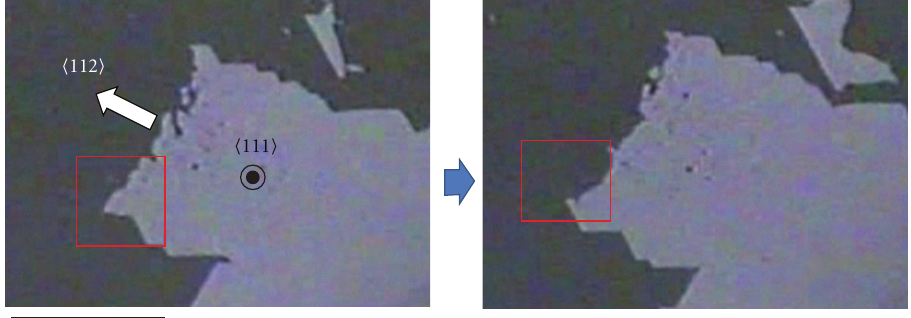
Figure 16: Growth behavior of Si (cid:4) 112 (cid:5) faceted dendrite observed perpendicular to { 111 } twins. Triangular corners of angle 60 ◦ are formed at the growth, tip and the direction of the corner changes with growth